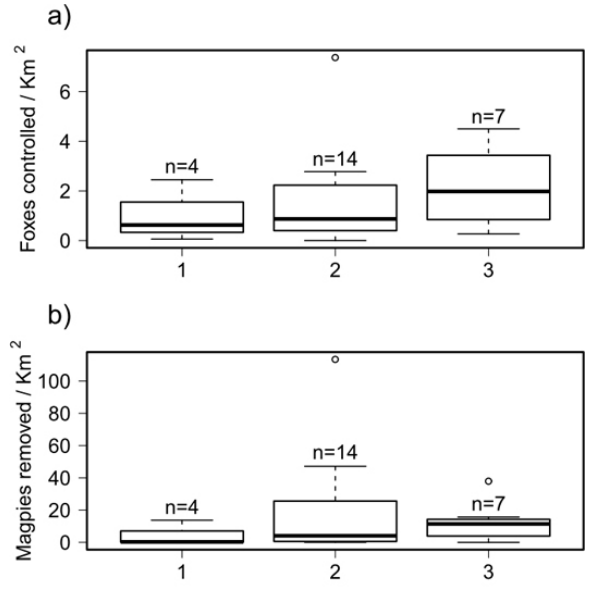
Fig. 2 . Proportion of estates (in black) that used different methods for controlling